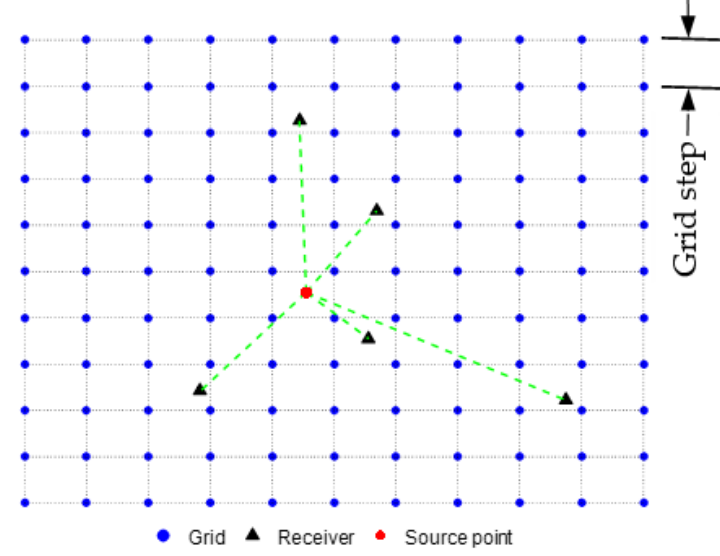
Figure 3. Illustration of the discretized 2D region in a lightning location network.